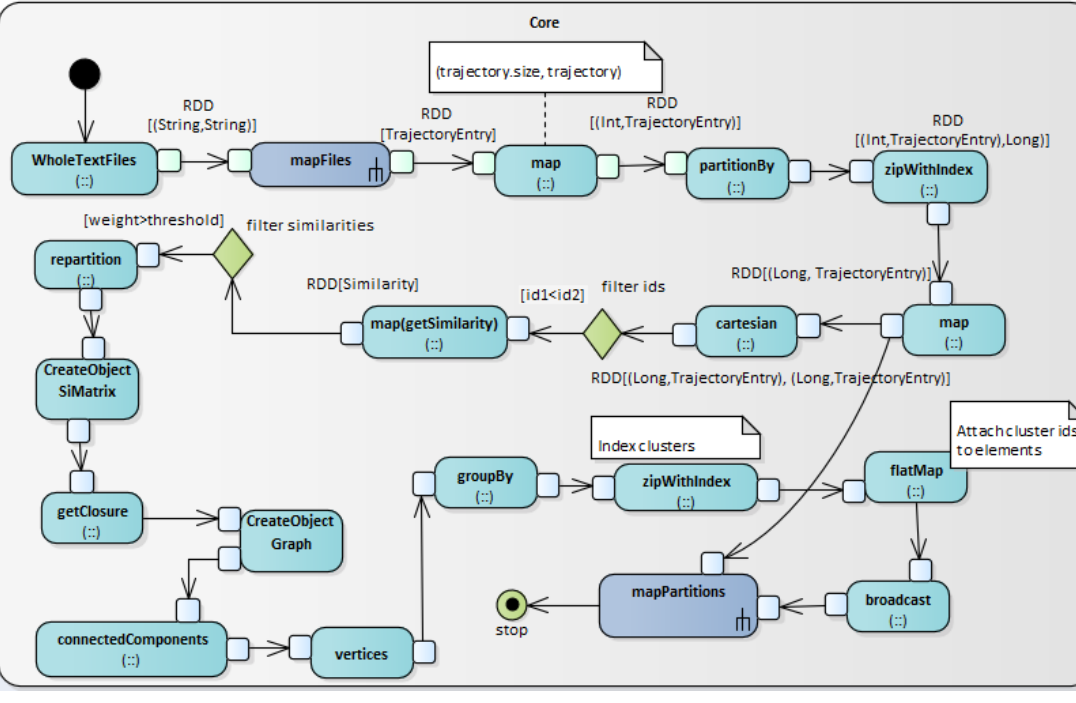
Figure 3. The execution pipeline main activity diagram.